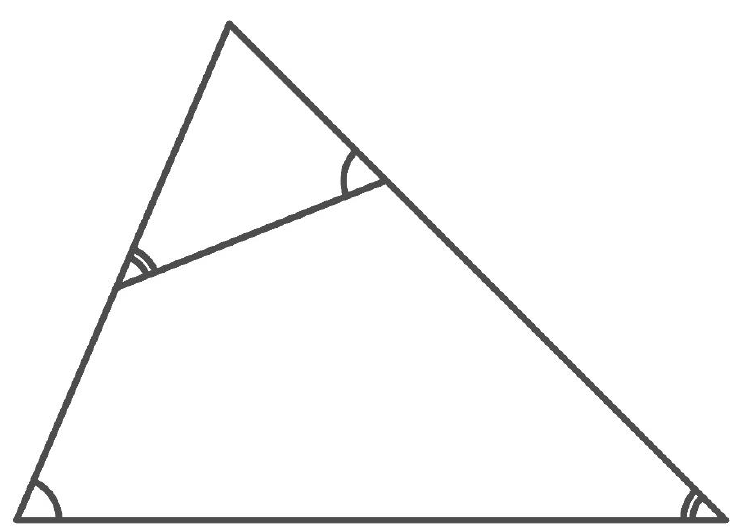
Figure 1. Example of triangles subcontraries, namely two triangles that are similar, have a common angle and have opposite sides to the common angle that are not parallel.